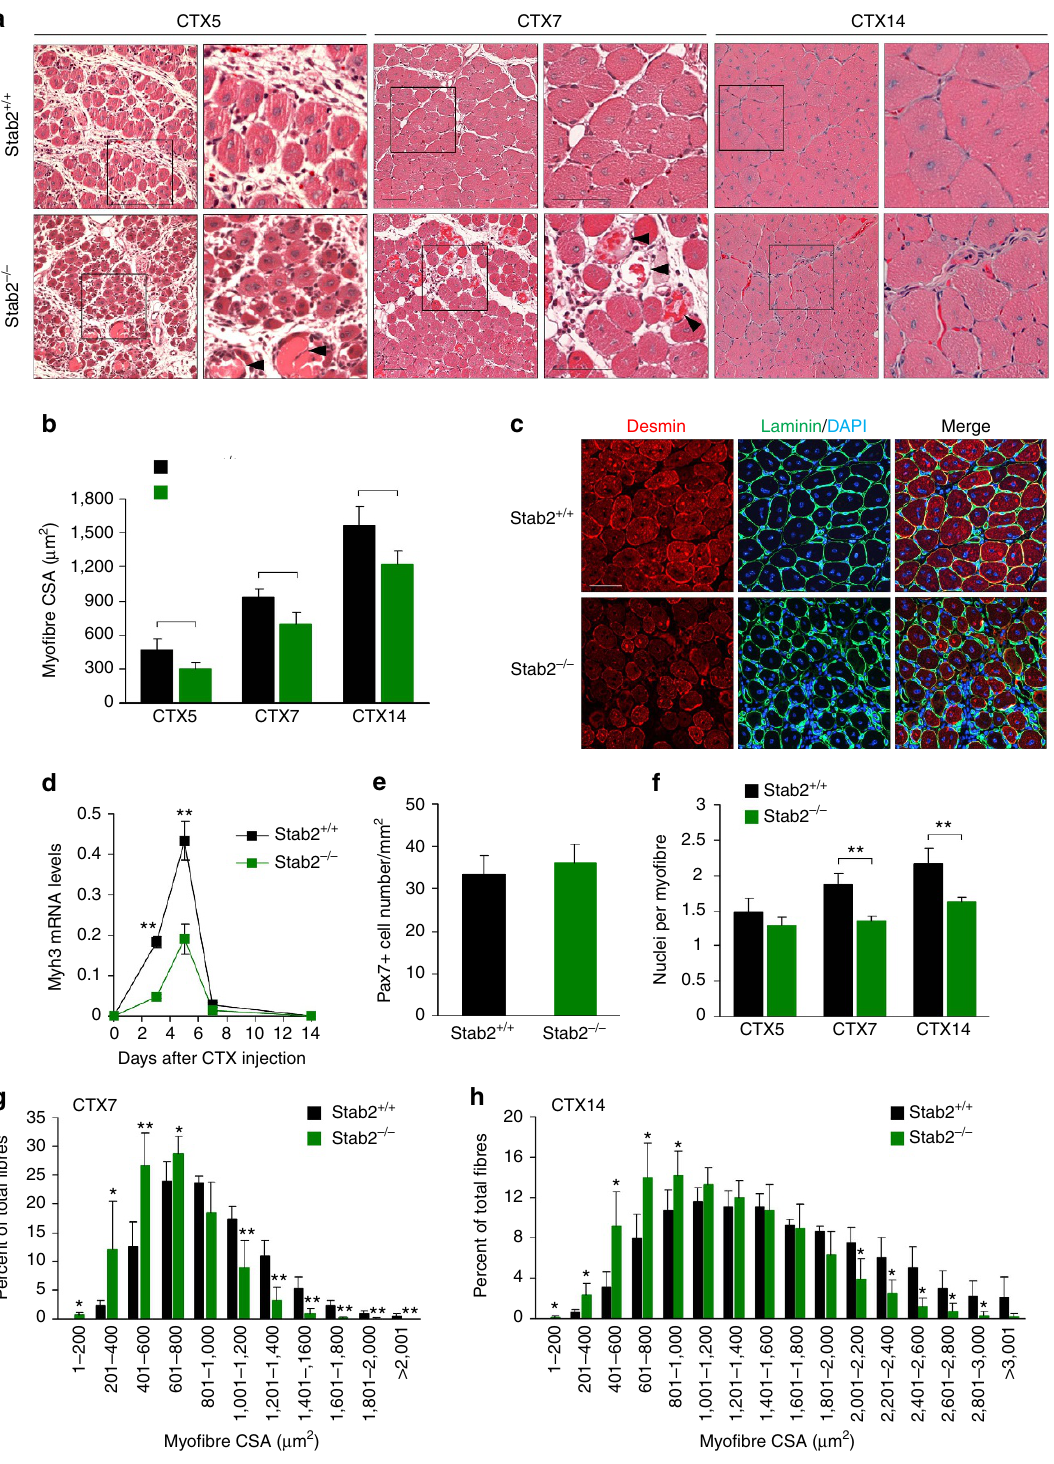
Figure 6 | Muscle regeneration is impaired in Stab2 (cid:2) / (cid:2) mice. ( a ) H&E staining of cross sections of Stab2 þ / þ and Stab2 (cid:2) / (cid:2) TA muscles at CTX5, CTX7, and CTX14 (days 5, 7, and 14 after CTX injection). Representative sections are shown. Black boxes are shown at higher magnification. Black arrowheads indicate necrotic myofibres. Scale bars, 50 m m. ( b ) Cross-sectional areas (CSAs) of regenerating myofibres were analysed at CTX5, CTX7, and CTX14 using the Image J program. Data are presented as mean ± s.d. ( n ¼ 5 per time point) of each group. ( c ) Immunostaining for desmin and laminin in Stab2 þ / þ and Stab2 (cid:2) / (cid:2) TA muscles at 7 days after CTX injection. Scale bar, 50 m m. ( d ) The levels of embryonic MyHC ( Myh3 ) mRNA were analysed in TA muscle of wild-type and Stab2-deficient mice during muscle regeneration after CTX injury. Data are presented as mean ± s.d. of at least three independent experiments. ( e ) The number of pax7-positive satellite cells per mm 2 was counted for TA muscles of wild-type and Stab2-deficient mice ( n ¼ 5). ( f ) DAPI-stained nuclei within dystrophin-positive sarcolemma were analysed in regenerating muscles from Stab2 þ / þ and Stab2 (cid:2) / (cid:2) mice, and numbers of myonuclei per myofibre were calculated. Data are presented as mean ± s.d. ( n ¼ 5) of each genotype. ( g , h ) The distributions of fibre sizes at CTX7 ( g ) and CTX14 ( h ) were analysed. More than 2,000 fibres were measured in each sample ( n ¼ 5). Data are presented as mean ± s.d. ( n ¼ 5). Asterisks indicate statistical significance (* P o 0.05, ** P o 0.01, Student’s t -test). NATURE COMMUNICATIONS|7:10871|DOI: